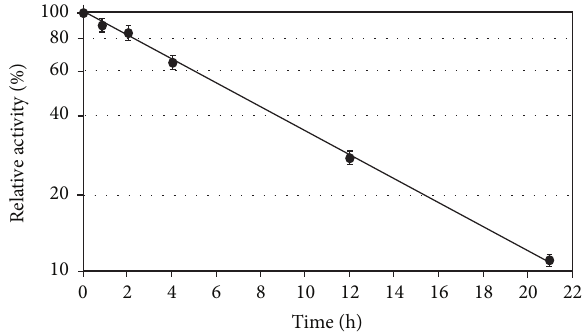
Figure 3: Thermal inactivation of recombinant Asac 1390. Purified Asac 1390 was preincubated at 90 ∘ C followed by 𝛽 -galactosidase assay. Data represent the means of three experiments and error bars represent standard deviation.